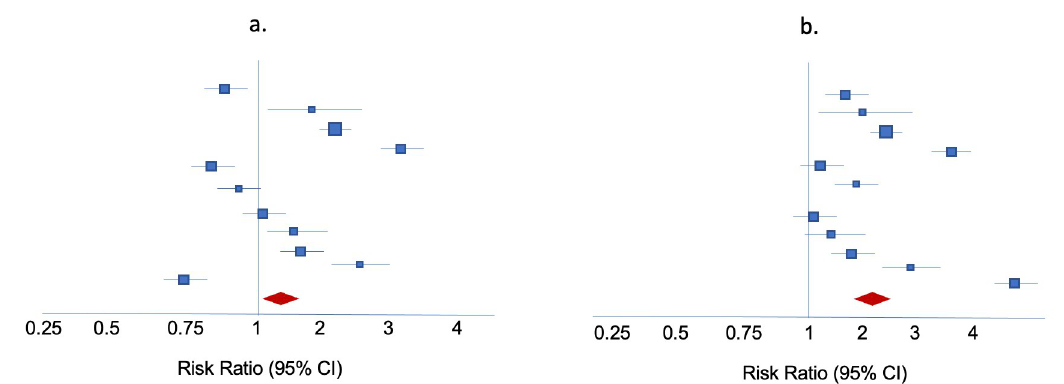
Fig 1. Examples of 2 hypothetical meta-analyses with high statistical heterogeneity but with differing interpretations of overall direction of effect estimates. (a) High statistical heterogeneity with inconsistency in direction of effects (uncertain benefit or harm). (b) High statistical heterogeneity with consistency in direction of effects (benefit). Blue boxes represent effect estimates from individual studies; red diamonds represent pooled effect estimates. Risk ratio greater than 1 represents benefit, less than 1 represents harm